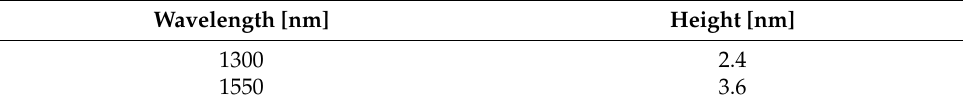
Table 2. Simulated optimal size of a InAs/InAlAs QD with a fixed AR of